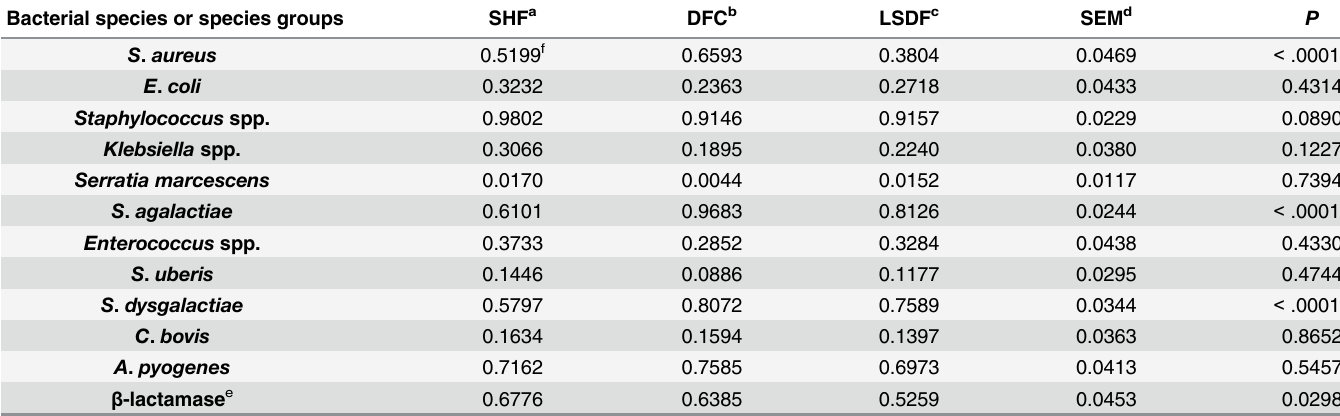
Enterococcus spp.